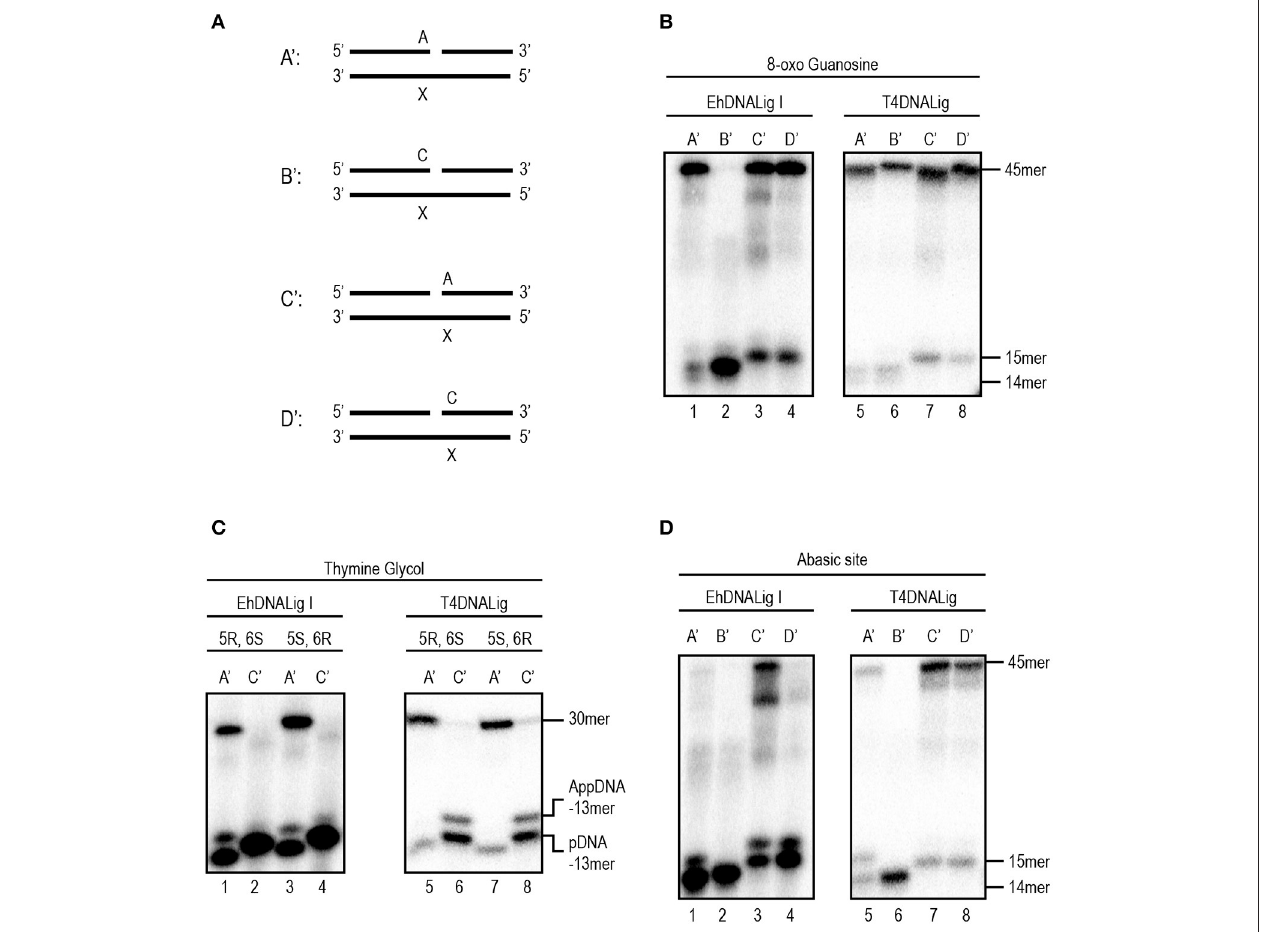
FIGURE 2 | EhDNALigI activity on substrates with oxidative stress damage. (A) Schematic representation of the assayed substrate to measure DNA ligation at damaged substrates. The “X” indicates the location of three oxidative damages: 8-oxoG, thymine glycol and abasic site. In all cases, the damage is located at the template strand, while the complementary strand may have an adenine or cytosine, located at the 3 ′ -OH (acceptor) (A’ and B’) or 5 ′ -PO 4 (donor) (C’ and D’). (B) Ligation reaction with 8-oxoG template. Enzymatic activity against damaged substrates with different combinations as shown in (A) using EhDNAligI (lanes 1–4) or T4 DNA ligase (lanes 5–8). (C) Ligation reaction with thymine glycol template. Enzymatic activity against damaged substrates with different combinations as shown in (A) using EhDNAligI (lanes 1–4) or T4 DNA ligase (lanes 5–8). (D) Ligation reaction with abasic site. Enzymatic activity against damaged substrates with different combinations as shown in (A) using EhDNAligI (lanes 1–4) or T4 DNA ligase (lanes 5–8). pDNA indicates the phosphorylated substrate DNA, while AppDNA indicates adenylated substrate by a DNA ligase. The substrate and the ligation product are labeled with